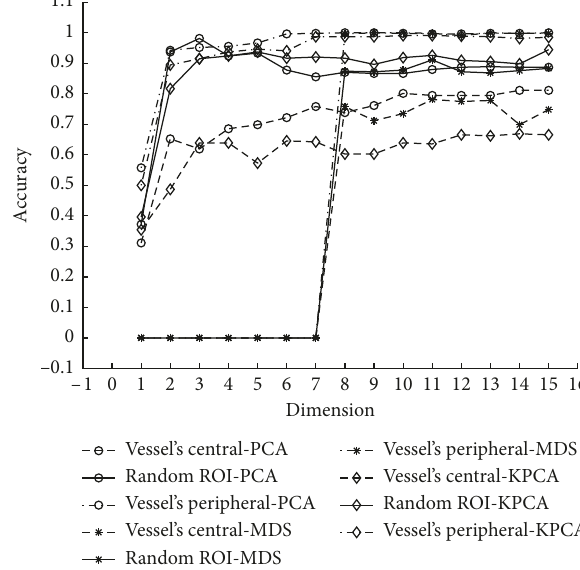
Figure 8: Spectral classification comparisons with MD